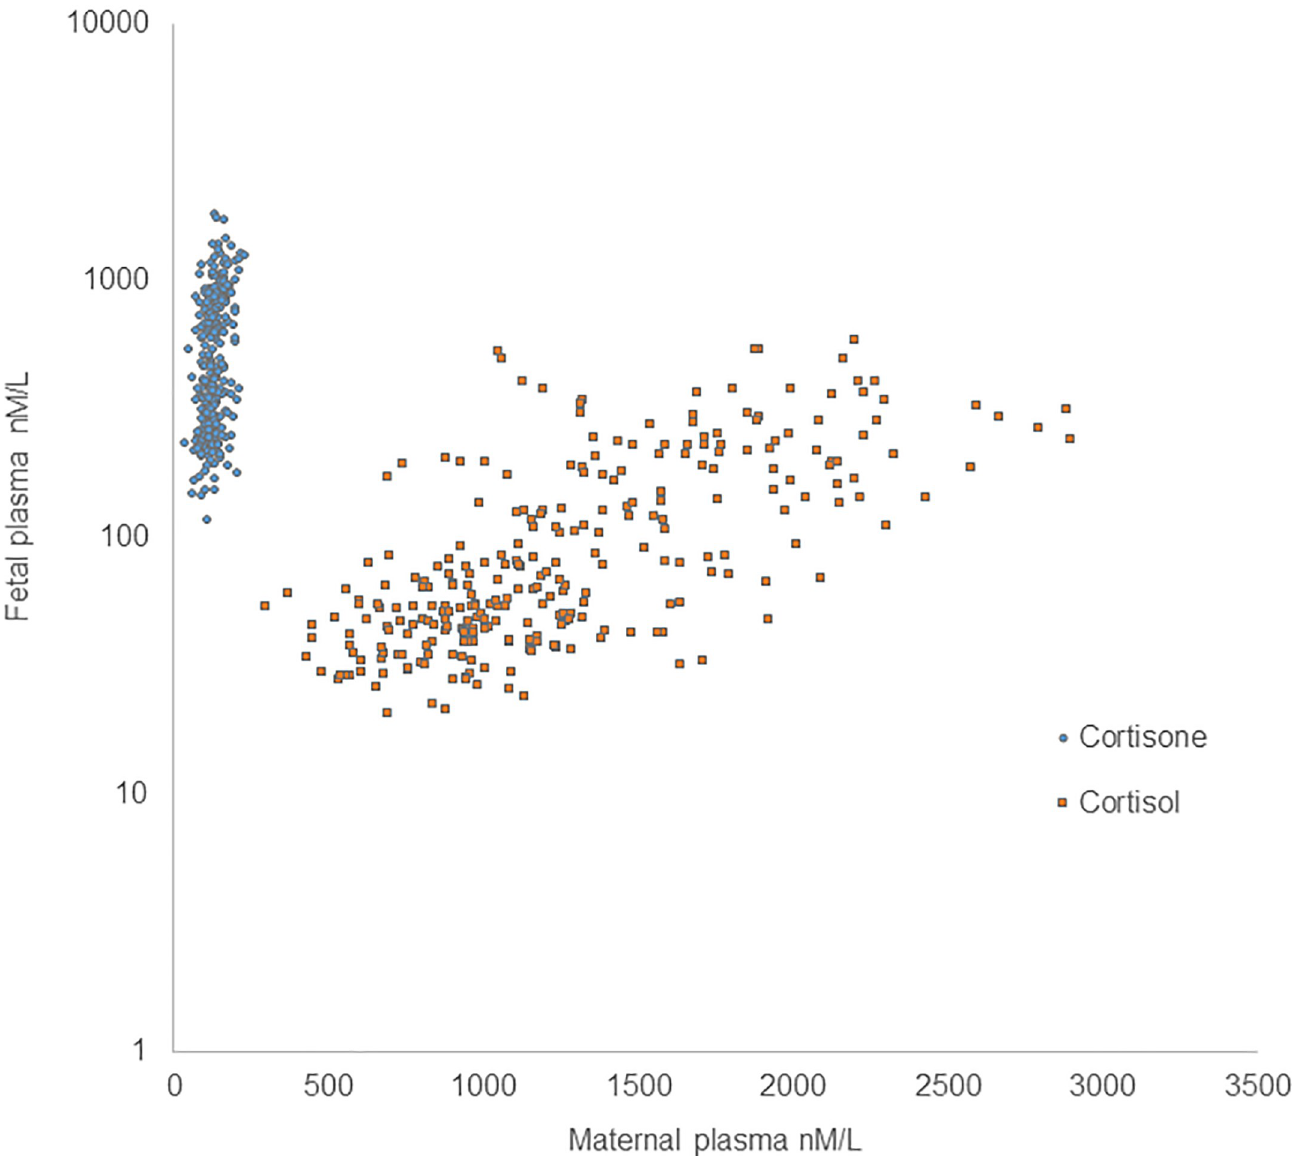
Fig 1. Fetal and maternal cortisone and cortisol. The y-axis is log-scale. Both fetal and maternal plasma cortisone (blue circle) and fetal and maternal cortisol (orange square) values correlate.